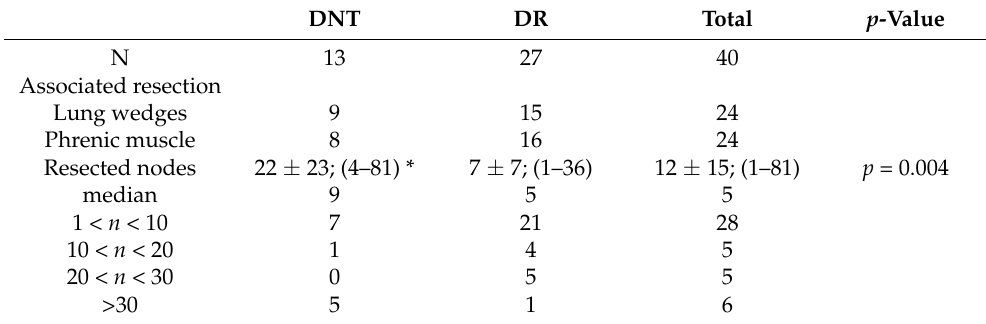
Table 2. Intra-operative findings.